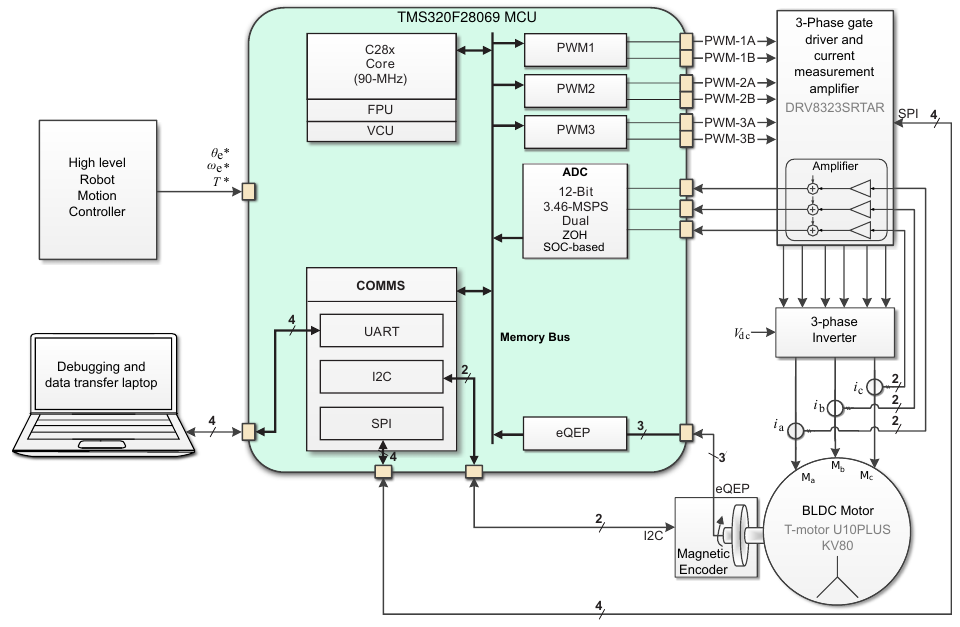
Figure A4. Illustration of all relevant communication between the TMS320F28069 DSP and the external components which are utilized in the motor controller PCB (manufactured at University of Southern Denmark